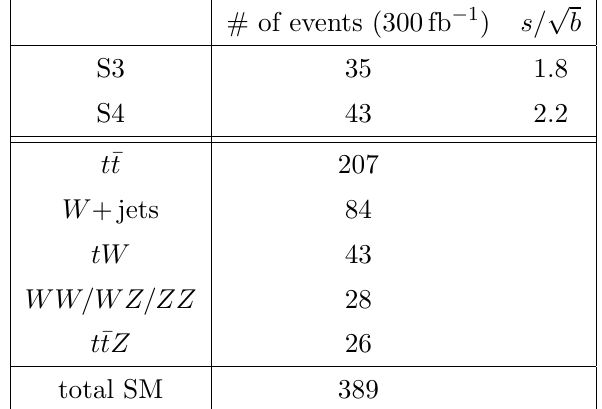
p b after all of